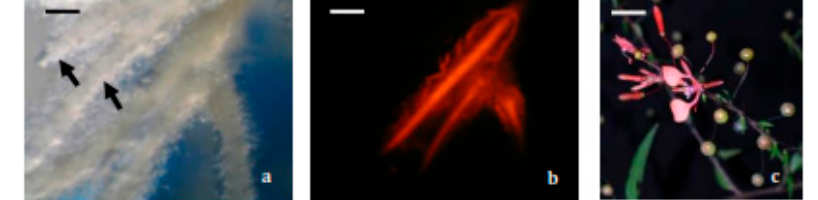
Figure 1. Photomicrographs (5×) of genetically transformed hairy roots of Lopezia racemosa . The same field observed under epifluorescence microscopy: ( a ) observed under white light; ( b ) observed under green light (550 nm). On the left upper part (arrows) non-fluorescent hairy roots derived from the same explant can be observed; ( c ) Lopezia racemosa wild plant. Scale bars: a and b : 1.0 mm; c : 1.0 cm.